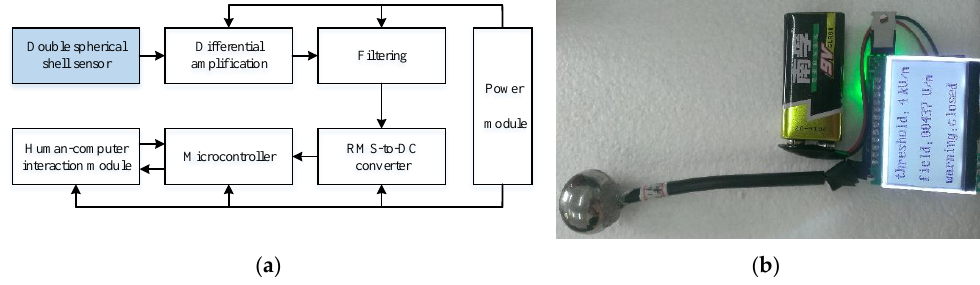
Figure 7. Overall design of the portable electric field measurement system. ( a ) Structure diagram. ( b ) Physical photograph.